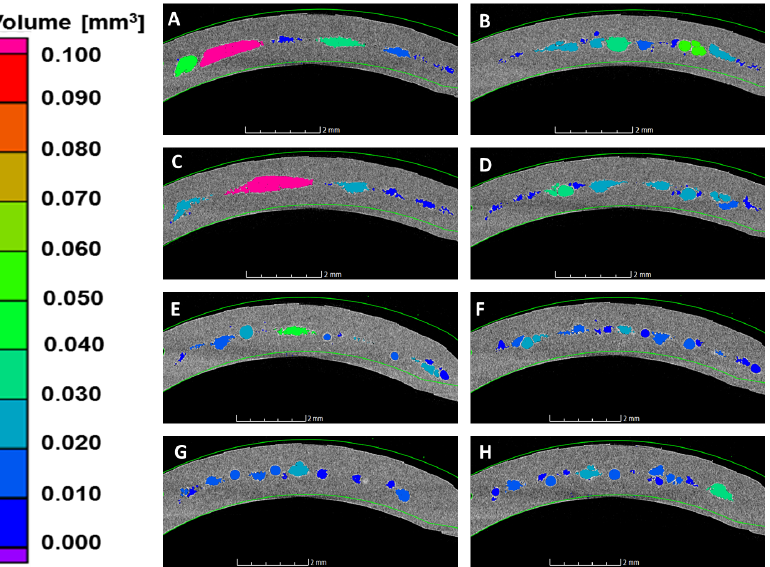
Figure 4. Cross sectional view at parting plane for process settings A to H (Table 3) at mold temperature of 80 °C.